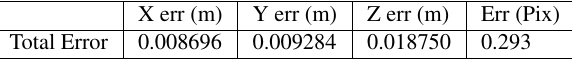
Table 2: Synthesis of the orientation residual after the optimiza-